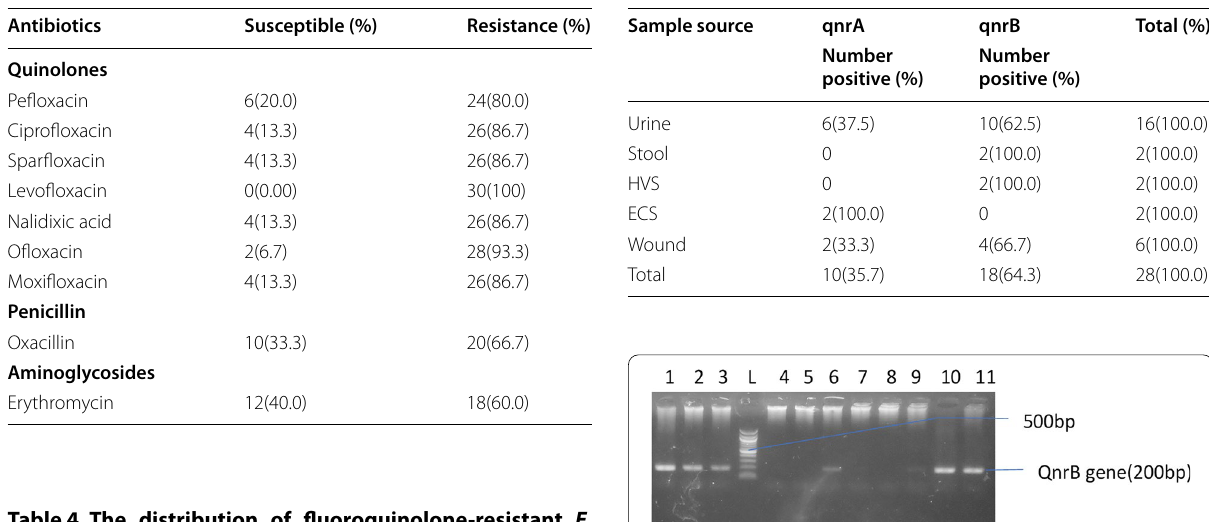
Table 4 The distribution of fluoroquinolone-resistant E.